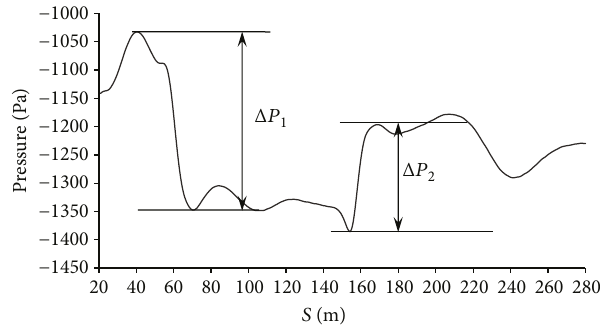
Figure 11: Curve of pressure changes at monitoring point h-11 under the train passing the air